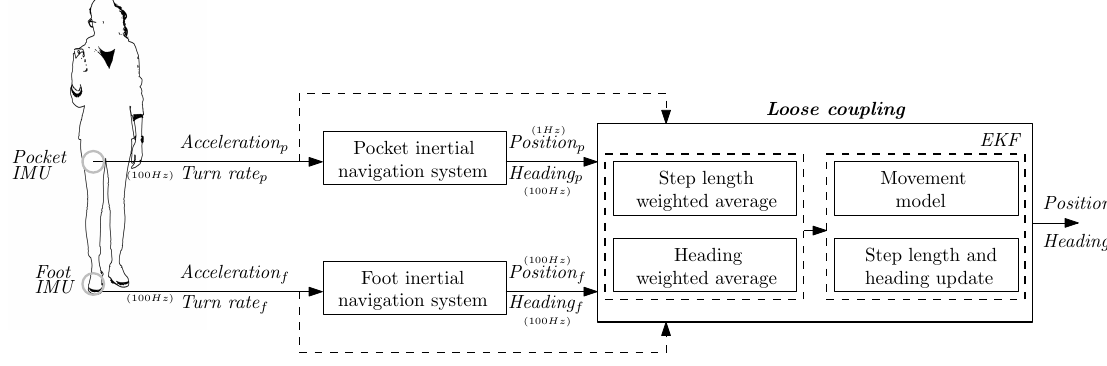
Figure 2. Loose coupling approach based on a pocket-mounted IMU and a foot-mounted